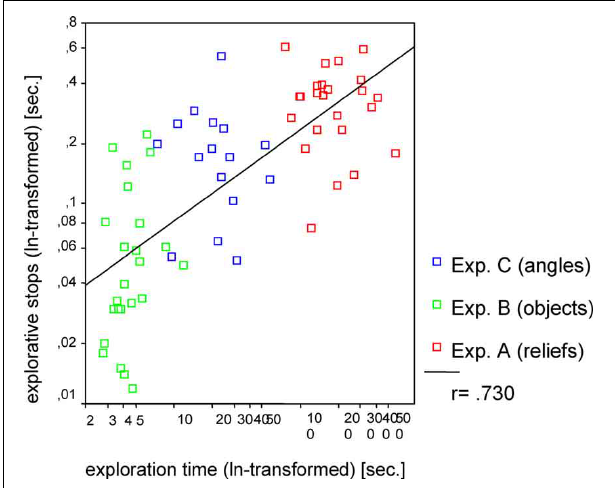
FIGURE 3 | Correlation between exploration time and explorative stops for Experiments A–C. Pearson correlation (one tailed) was used.